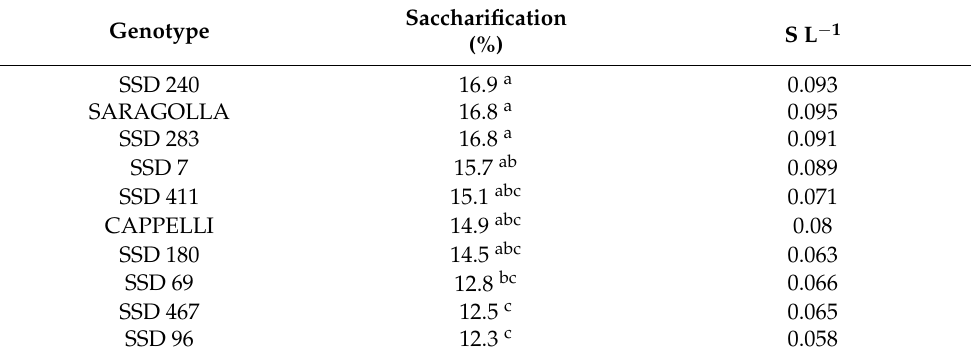
Table 4. Saccharification was expressed as percentage of glucose released after hydrolysis with respect to total sugars. The value S L − 1 was calculated as the ratio between saccharification and lignin content.